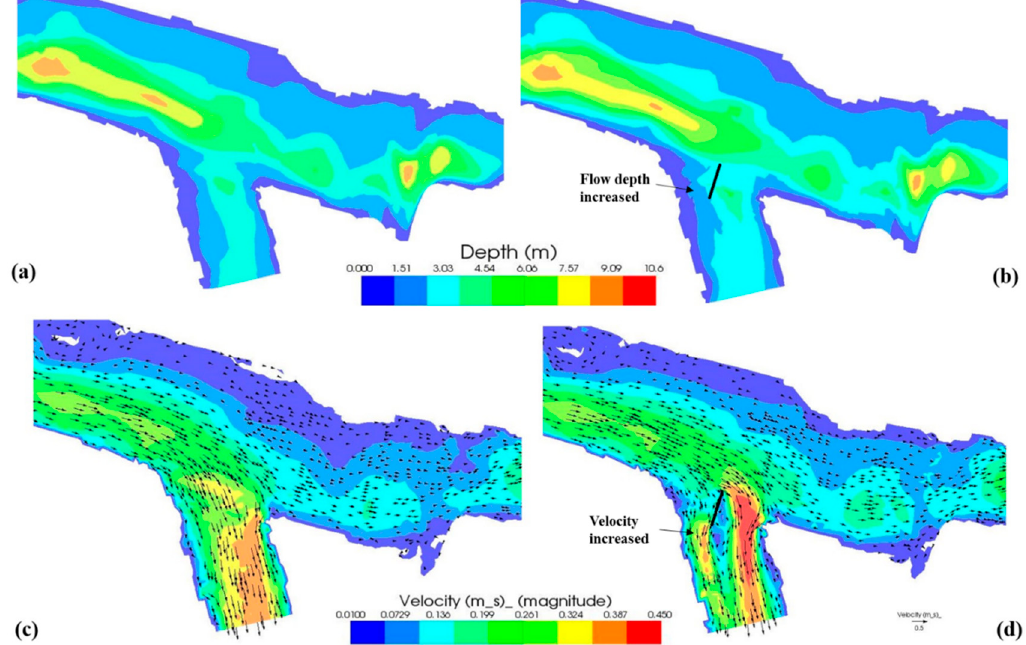
Figure 16. Simulation of flow depth and velocity distribution with its vectors during low flow conditions. ( a ) Simulated flow depth without vane; ( b ) Simulated flow depth with vane; ( c ) Simulated velocity distribution with its vectors without vane; ( d ) Simulated velocity distribution with its vectors with vane.